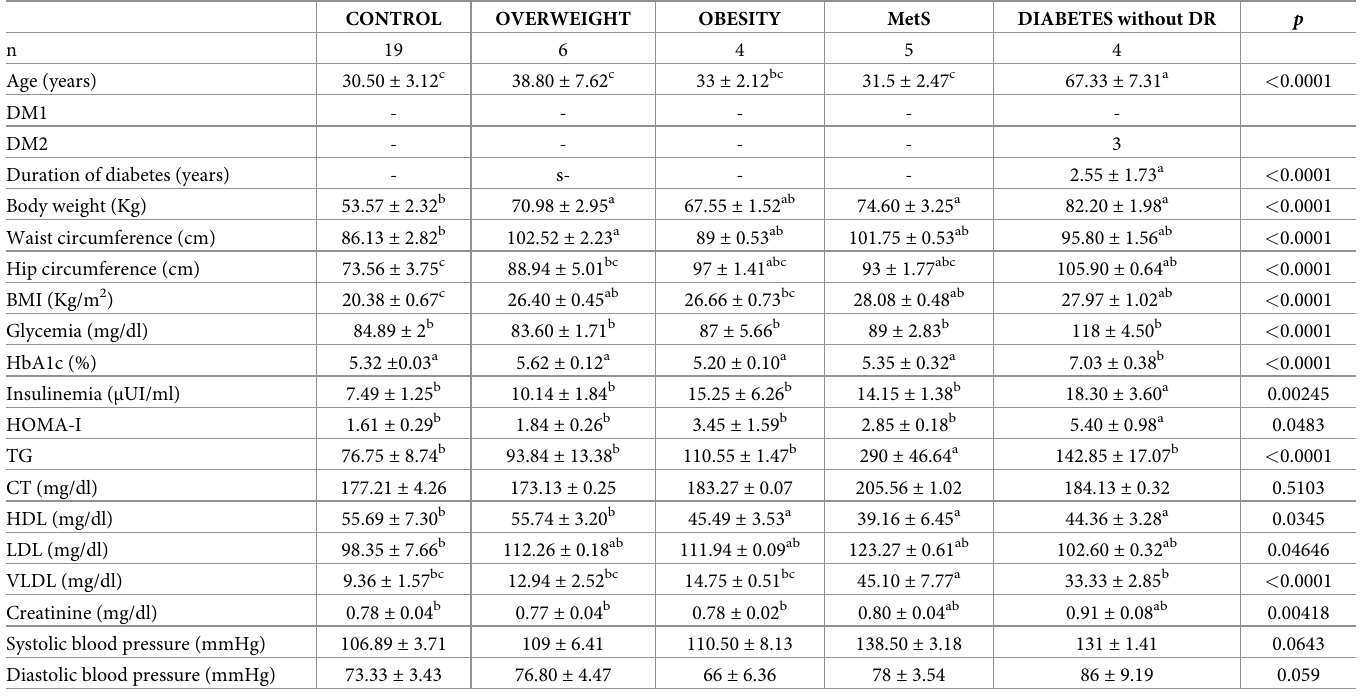
Table 2. Characteristics of the patients studied for external model